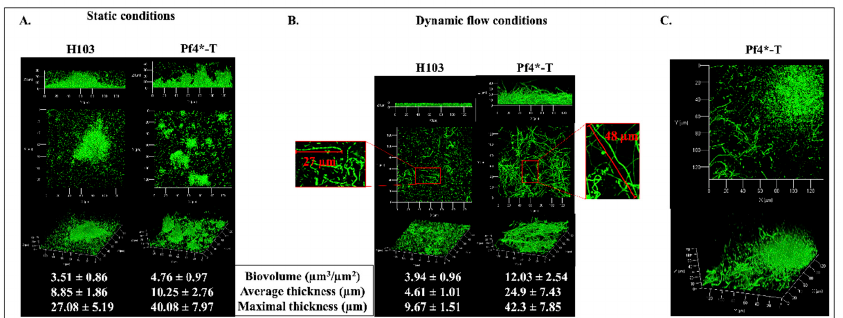
Figure 3. Pf4 phage variant infection leads to altered biofilm architecture and cell morphology. Side, top and three-dimensional views of 24 h-old biofilm of H103 untreated and treated with Pf4* phage grown under static ( A ) and dynamic conditions ( B , C ) observed by confocal laser scanning microscopy (CLSM). Cells were stained with SYTO9 green fluorescent dye. Values represent COMSTAT2 image analyses. Results were given ± SEM of at least three independent experiments. ( C ) Focus on microcolonies of the Pf4*-T biofilm grown in dynamic conditions. Each experiment was assayed at least four times independently.